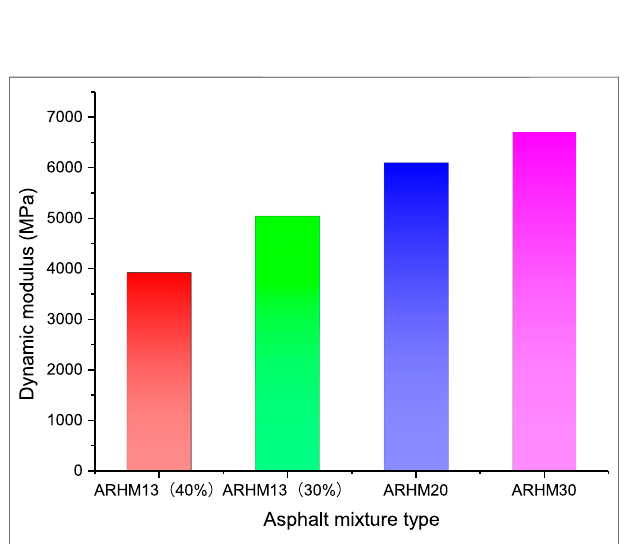
FIGURE 9 | Design value of dynamic modulus of asphalt mixture.